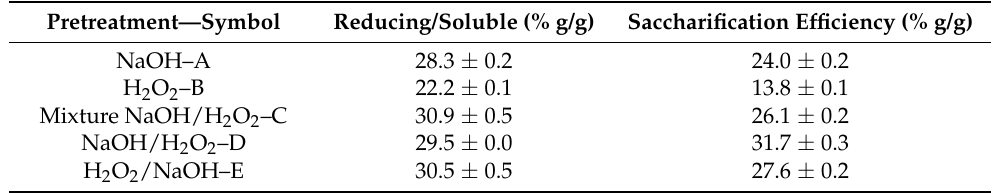
Table 2. Saccharification degree expressed as the ratio of reducing sugars to soluble carbohydrates and saccharification efficiency.